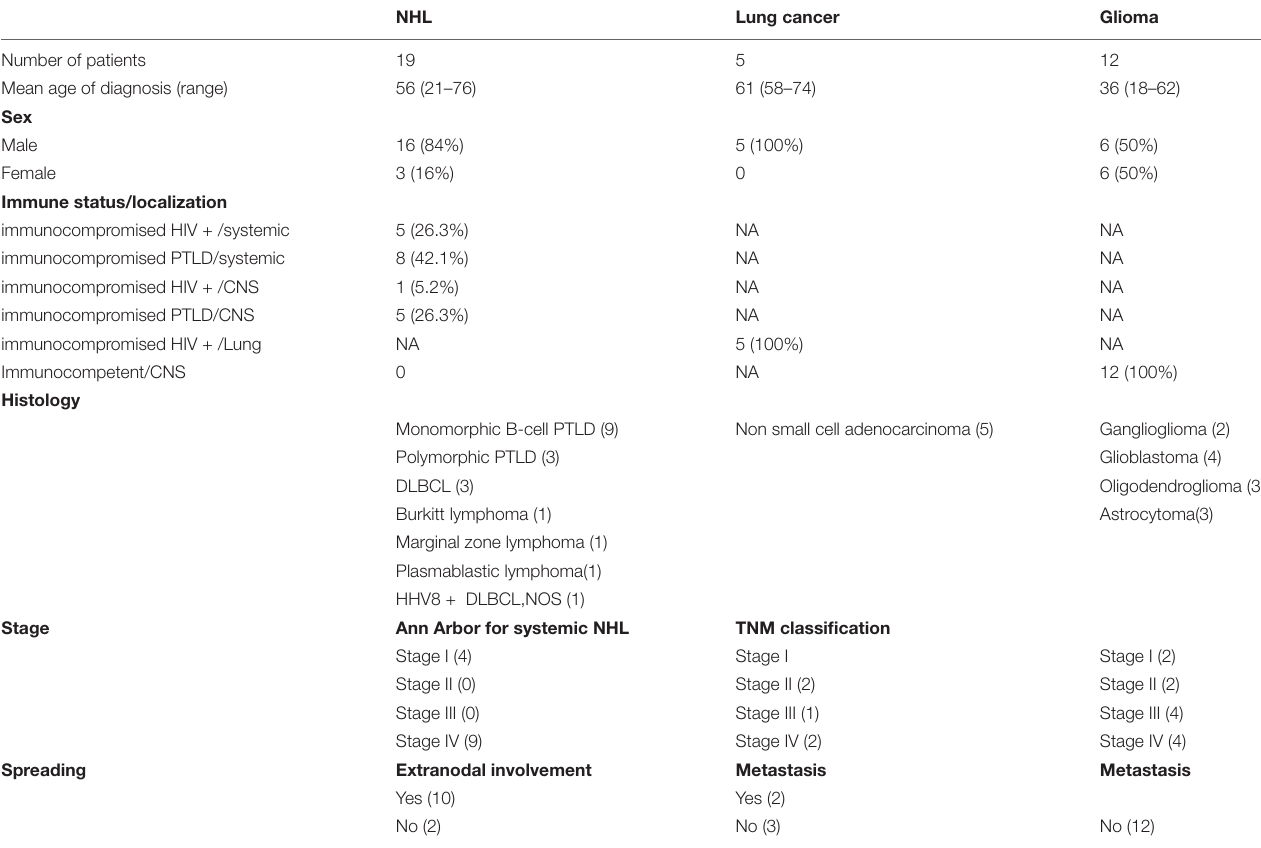
TABLE 1 | Study cohort